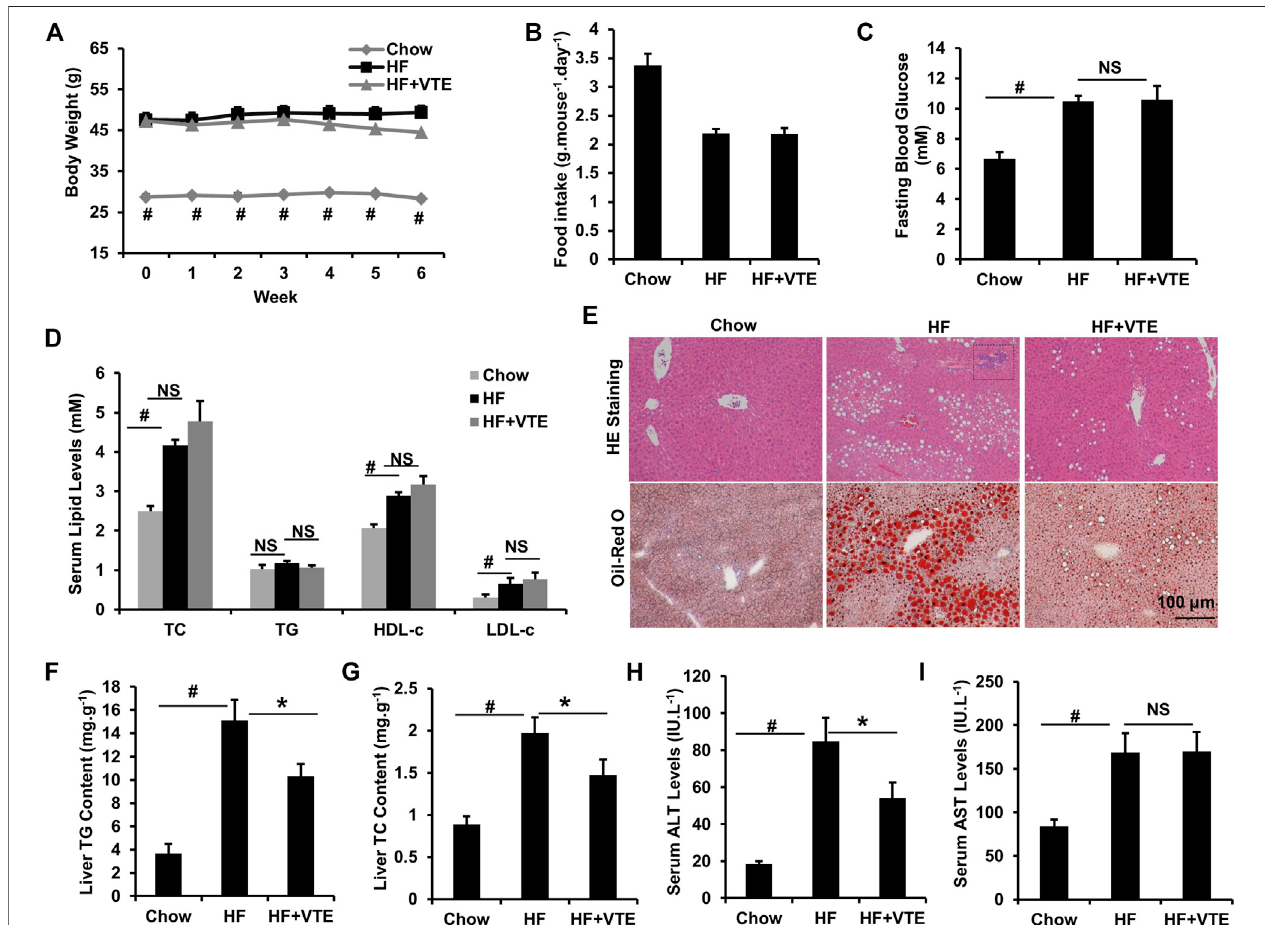
FIGURE 2 | VTE protects DIO mice from NAFLD. Obese C57BL/6J mice were fed with an HFD (high-fat diet) supplemented with or without VTE (1 g 100 g − 1 diet) for6 weeks (A) Bodyweightwasrecordedduringthe6-weekstreatment (B) Foodintakeamount (C) Fastingbloodglucose (D) Serumtotalcholesterol(TC),triglyceride (TG), high-density lipoprotein cholesterol (HDL-c), low-density lipoprotein cholesterol(LDL-c) levels (E) Haematoxylin and eosin (H and E) and Oil Red O staining of livers fromthechowdiet-,HFdiet-,andHF+VTE-fedmice.Scalebars,100 μ m (F) LiverTGlevels (G) LiverTClevels (H) SerumALTlevels (I) SerumASTlevels.Dataare statisticallyanalysedasmeans ± SEM( n (cid:2) 6pergroup). # p < 0.05,HFversusChowgroup.* p < 0.05,HFversusHF+VTEgroup.NS,nosigni fi cance.Dottedrectangles denote hepatic in fl ammatory cell in fi